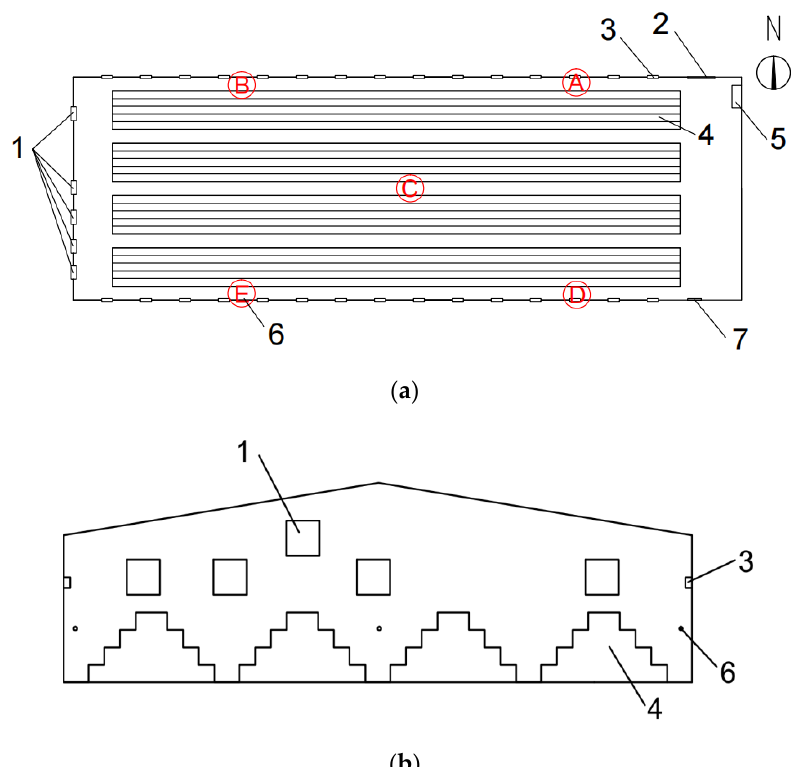
Figure 1. Layouts of layer house and measurement locations: ( a ) plane figure of the layer house; ( b ) section plan of the layer house. (1) fans, (2) wet curtain on the north side, (3) air vent, (4) laminate chicken cage, (5) inner door, (6) measurement point with a vertical height of 1.5 m, they are A, B, C, D and E, and (7) wet curtain on the south side.